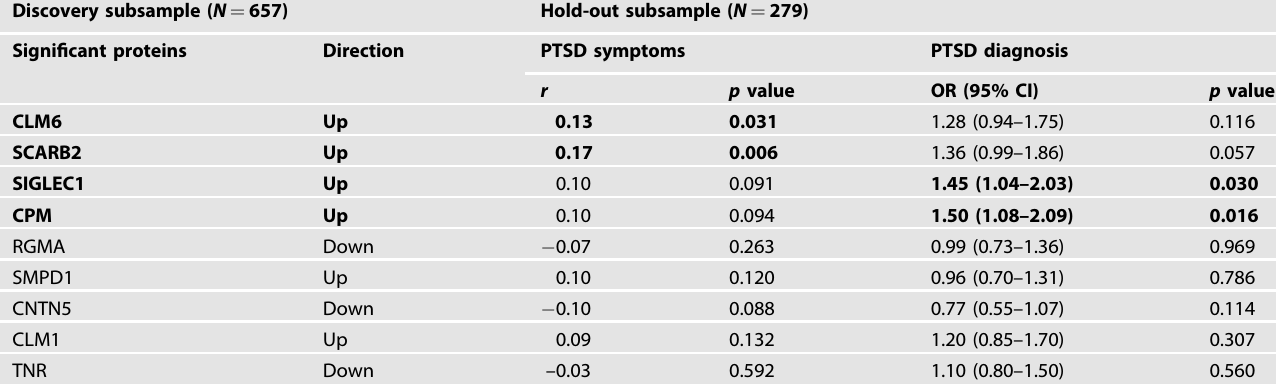
Table 2. Bivariate associations between signi fi cant proteins in the discovery subsample, and PTSD symptoms and diagnoses in the hold-out